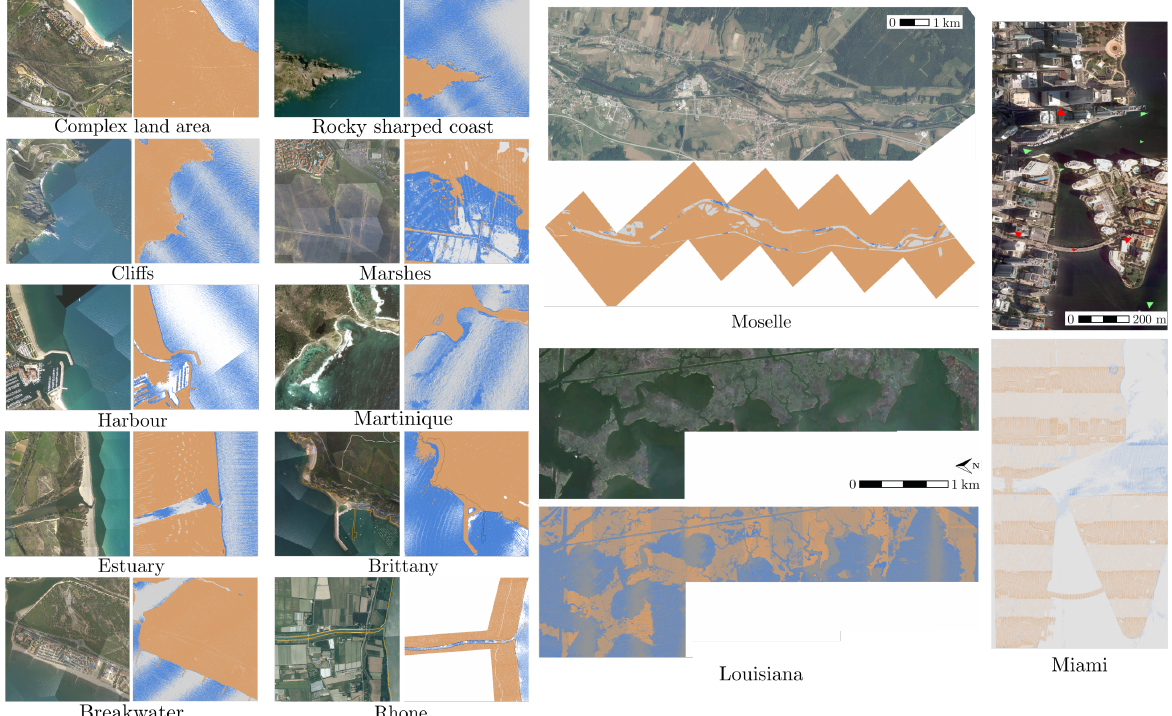
Figure 1: Results for the various areas of interest. Both orthoimages and classifications ar provided ( n Land – n Water – n No data). The ten areas on the left correspond to 1 km × 1 km tiles. The orange line shows the historical